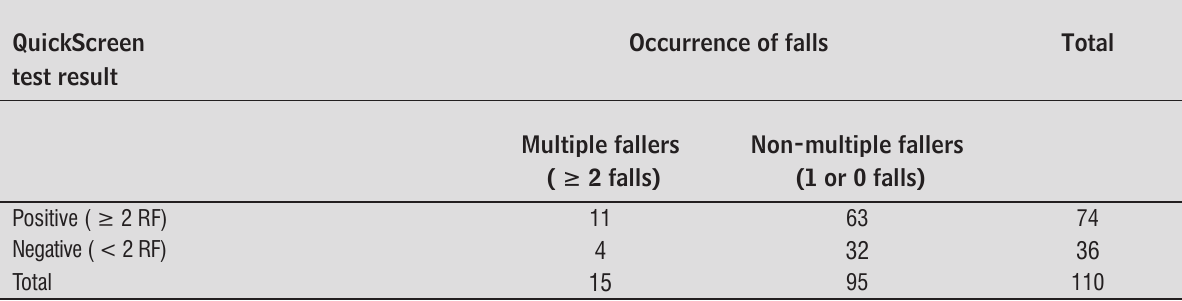
Table 3 - Composition of the validity indexes adopted in the study QuickScreen